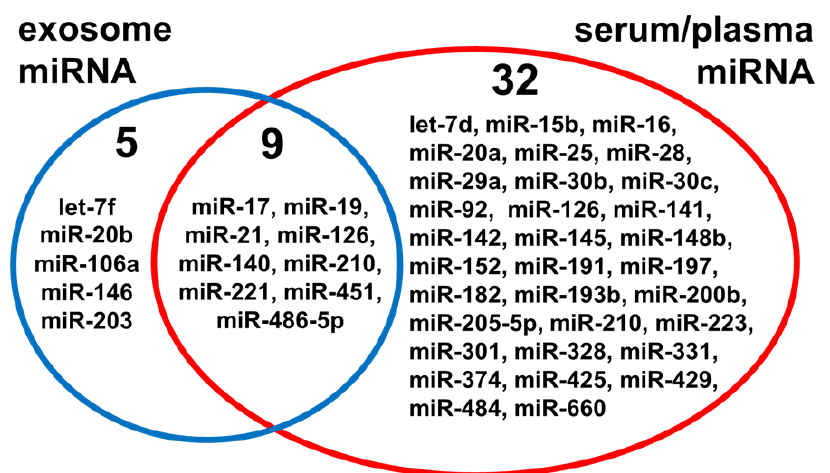
Figure 2. MicroRNA species present in lung cancer signatures. Showed are components present in at least 2 signatures identified in either whole serum/plasma or serum/plasma-derived exosomes (small extracellular vesicles).